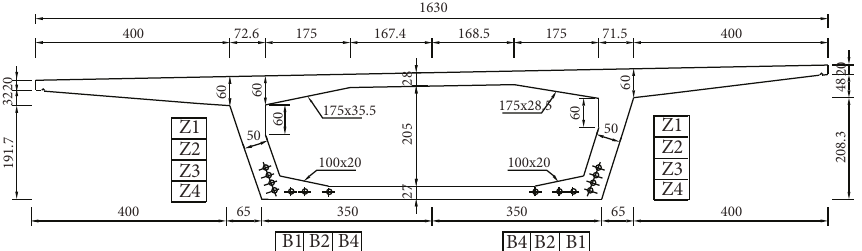
Figure 20: Mid-span section of optimized 40 m box girder (cm).